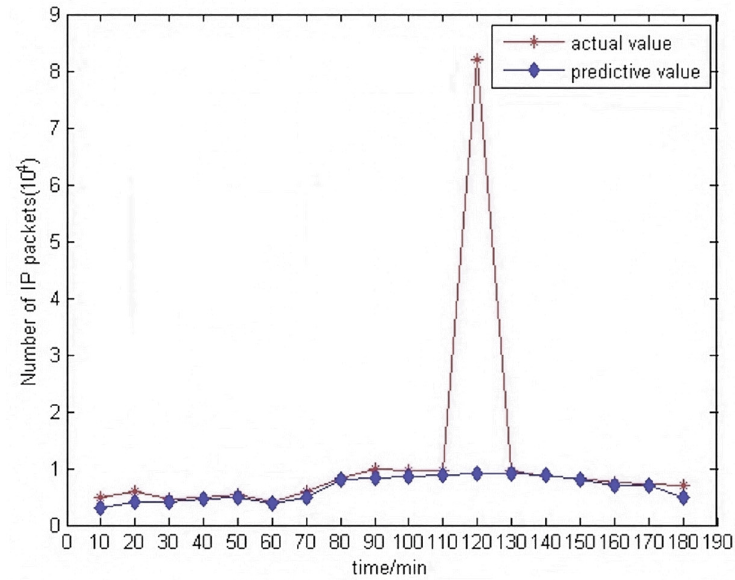
Figure 8. Results of the first DDoS simulated attack experiment.